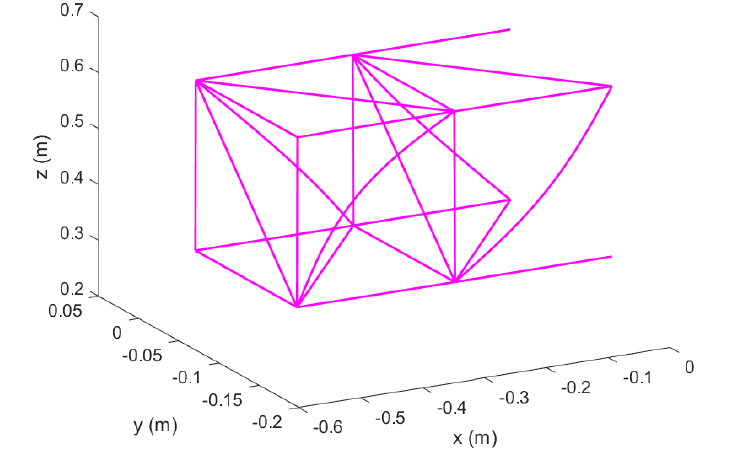
Figure 28. Mode 3 of Timoshenko beams in Topology 1 with hinged ends; original